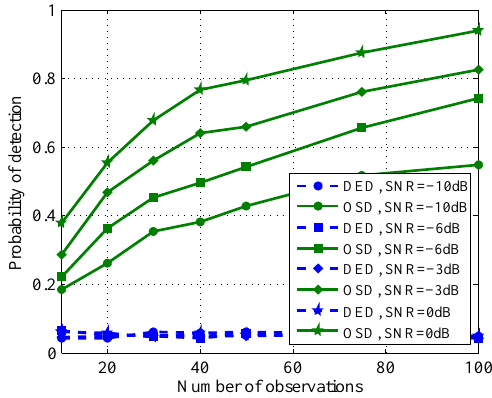
Figure 2. Probability of detection: DED and OSD vs. M for different SNRs | Constant primary signal | Nakagami-m fading: Shape parameter = 1 , Scale parameter = 0 . 5